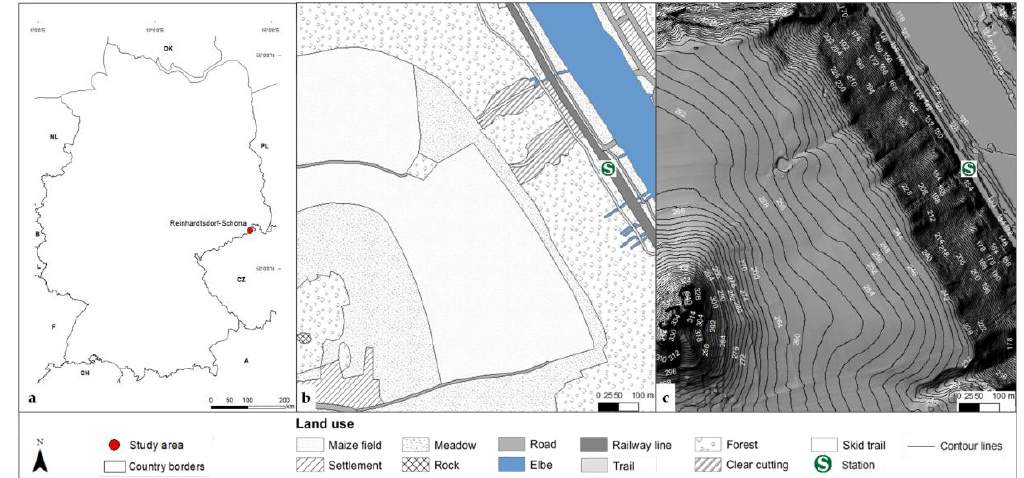
Figure 1. The study area in ( a ) Germany (data basis: [25]), ( b ) its land use and ( c ) its relief.